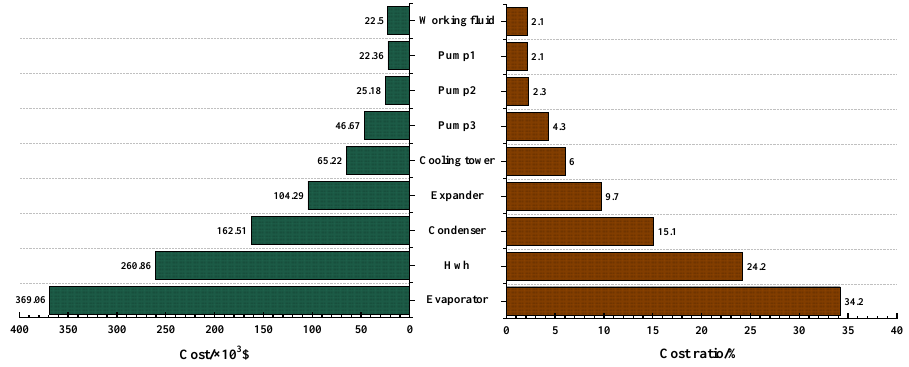
Figure 14. Component costs of SS.